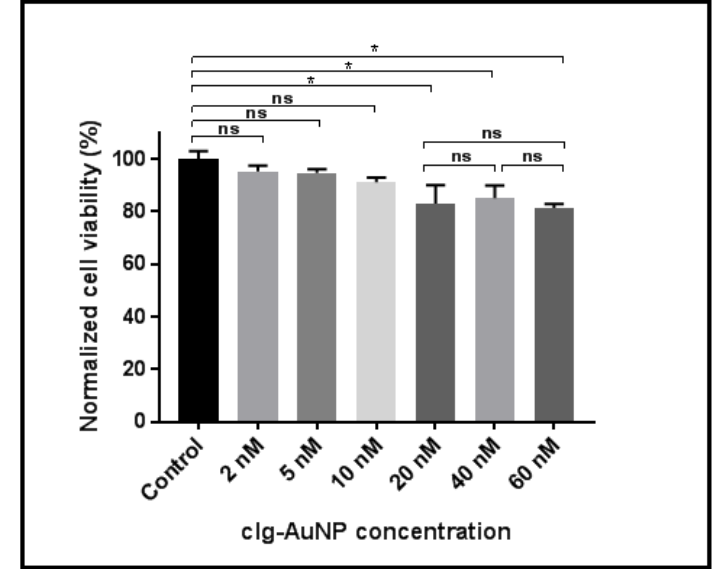
Figure 5. HeLa cellular viability at different clg-AuNPs concentration. Cellular viability was compared to untreated, control sample, and additionally in between groups, using ANOVA with multiple hypothesis testing (*p < 0.05).